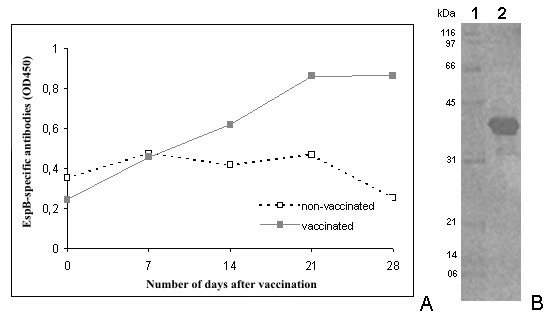
A: Detection of the EspB-specific serum antibodies of non-vaccinated and vaccinated rabbits as a function of time. Groups of 12 rabbits were used. The means were significantly different (P = 0.01) from day 14 onward. B: SDS-PAGE followed by silver-staining of a molecular weight standard (1) and purified recombinant EspB (2). The EspB band of approximately 40 kDa is clearly visible.